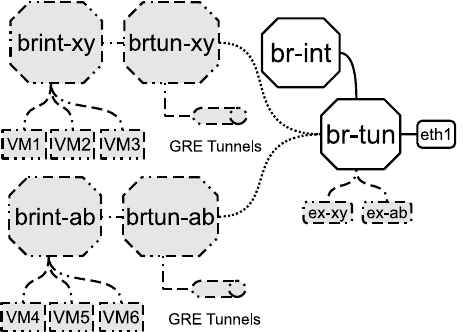
Fig. 1: Dedicated bridges for two tenants in a compute node.